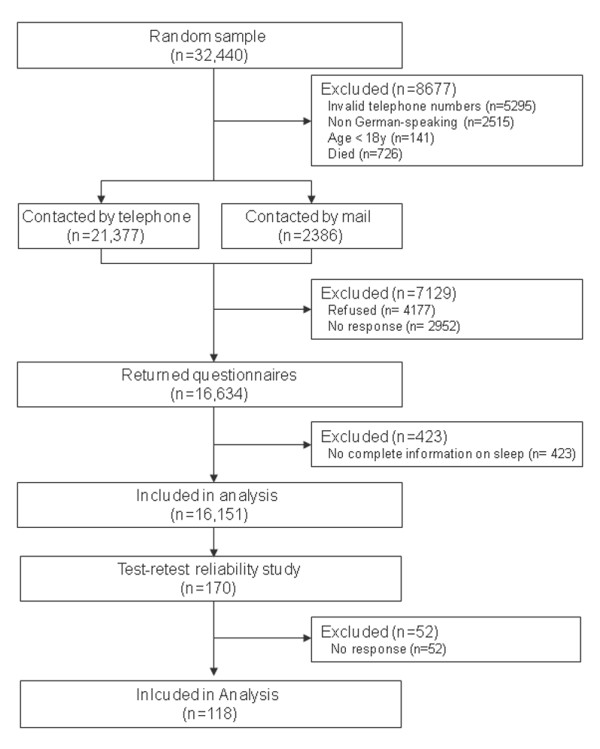
Study flowchart.